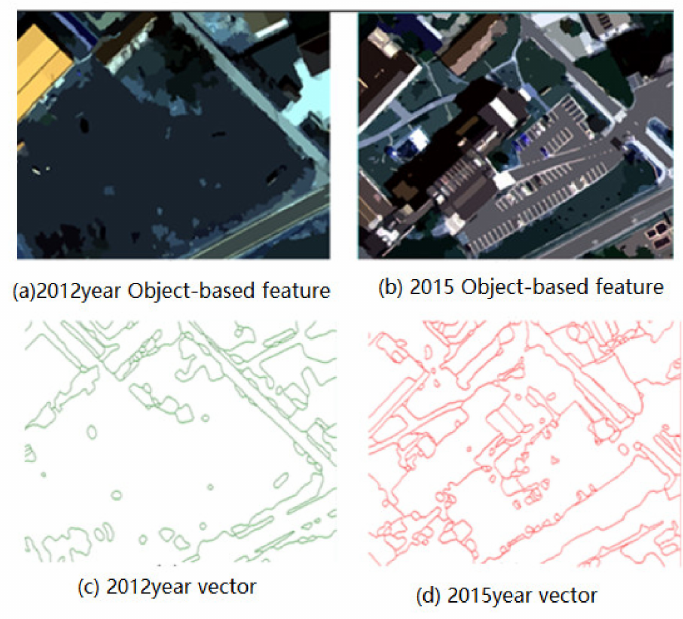
Figure 5. Object-based features and corresponding vectors.